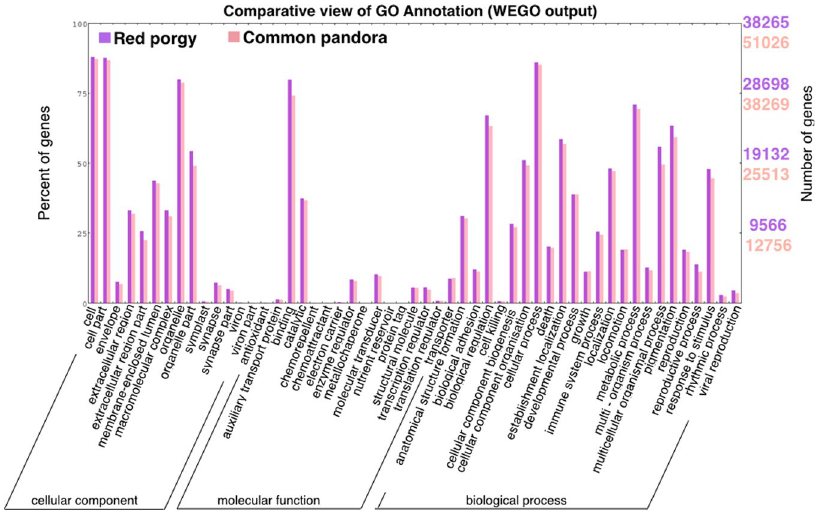
Figure 2. Comparative view of GO annotation. Comparison of Gene Ontology. (GO) categories (assigned by WEGO) between red porgy and common pandora. GO terms for the genes of red porgy (dark purple) and common pandora (pink) were categorized into cellular components, molecular functions and biological processes.